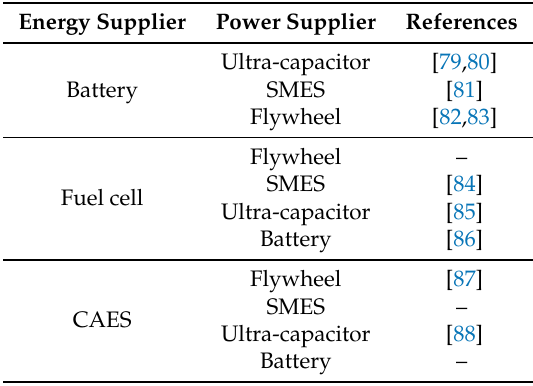
Figure 11. Ragone chart: Comparison of different energy storage technologies. Table 4. Possible hybrid energy storage systems (HESS)